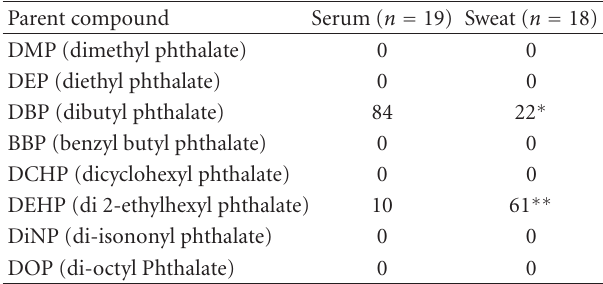
Table 3: Percentage of individuals with detection of parent phthalates in body compartments.